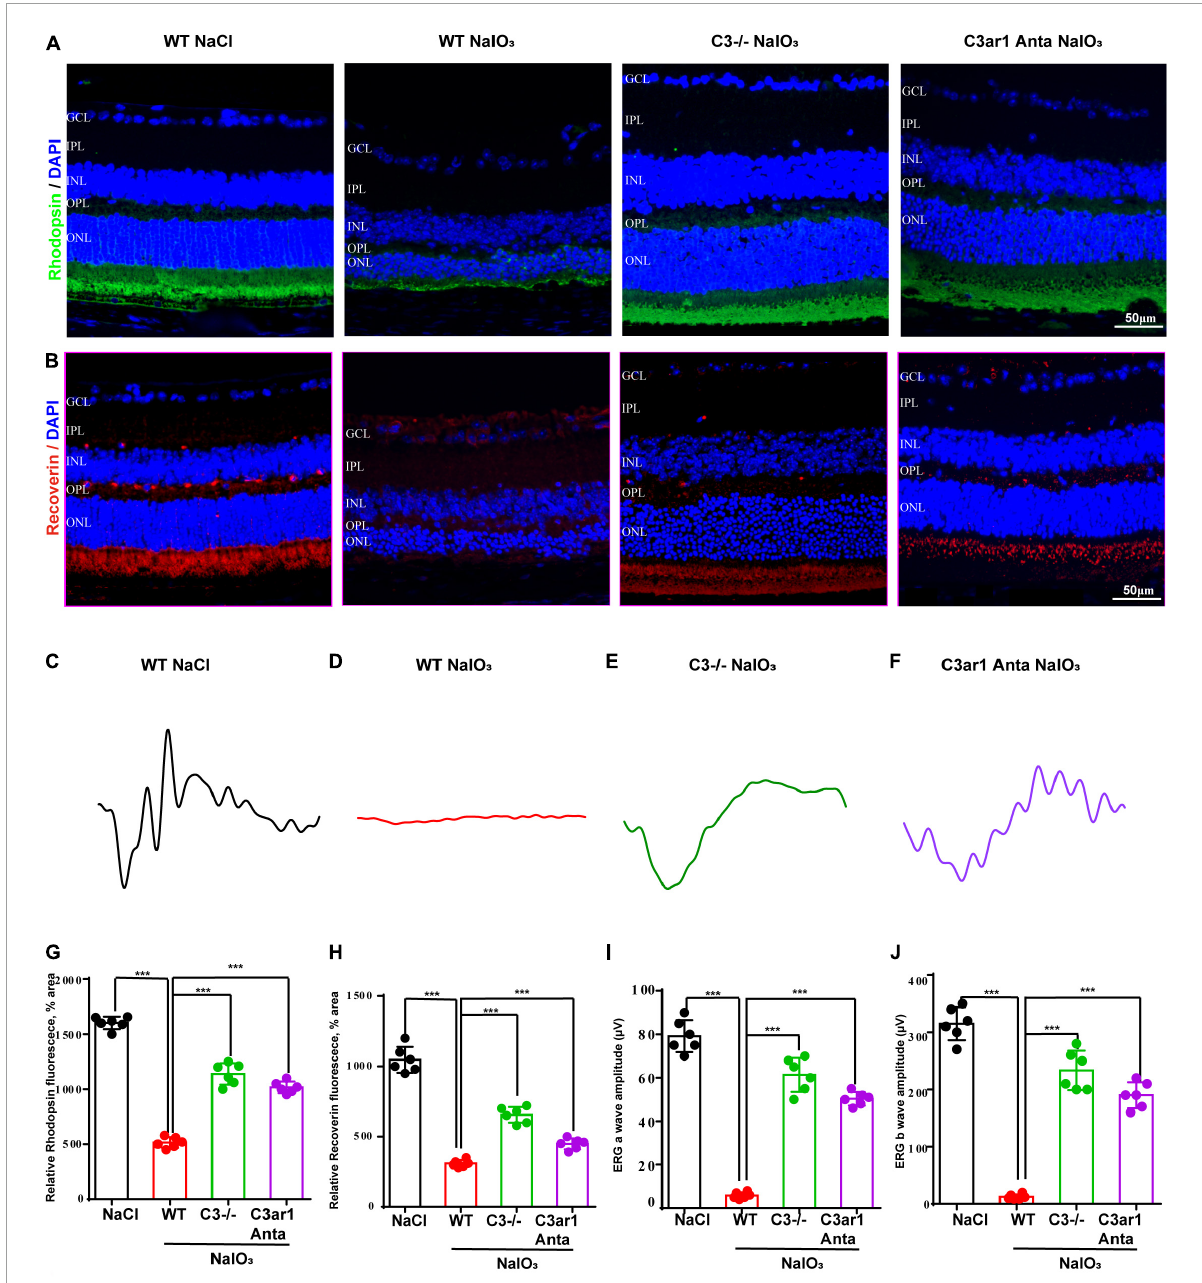
FIGURE6 Genetic deletion of C3 and inactivation of C3ar1 rescues the retinal function of wild-type mice after NaIO 3 induction. (A,B) Immunofluorescence staining of rhodopsin and recoverin in the retinas of saline control- and NaIO3-treated WT, C3-KO and C3ar1-inhibited mice. (C–F) ERG analysis of retinal function in saline control- and NaIO3-treated WT, C3-KO and C3ar1-inhibited mice (dMax 3.0). (G,H) Quantification of rhodopsin and recoverin in the retinas of saline control- and NaIO3-treated WT, C3-KO and C3ar1-inhibited mice. (I,J) Bar plot of the amplitudes of a and b waves in saline control- and NaIO3 treated WT, C3-KO and C3ar1-inhibited mice (mean ± SEM, n = 6. *** p < 0.001).